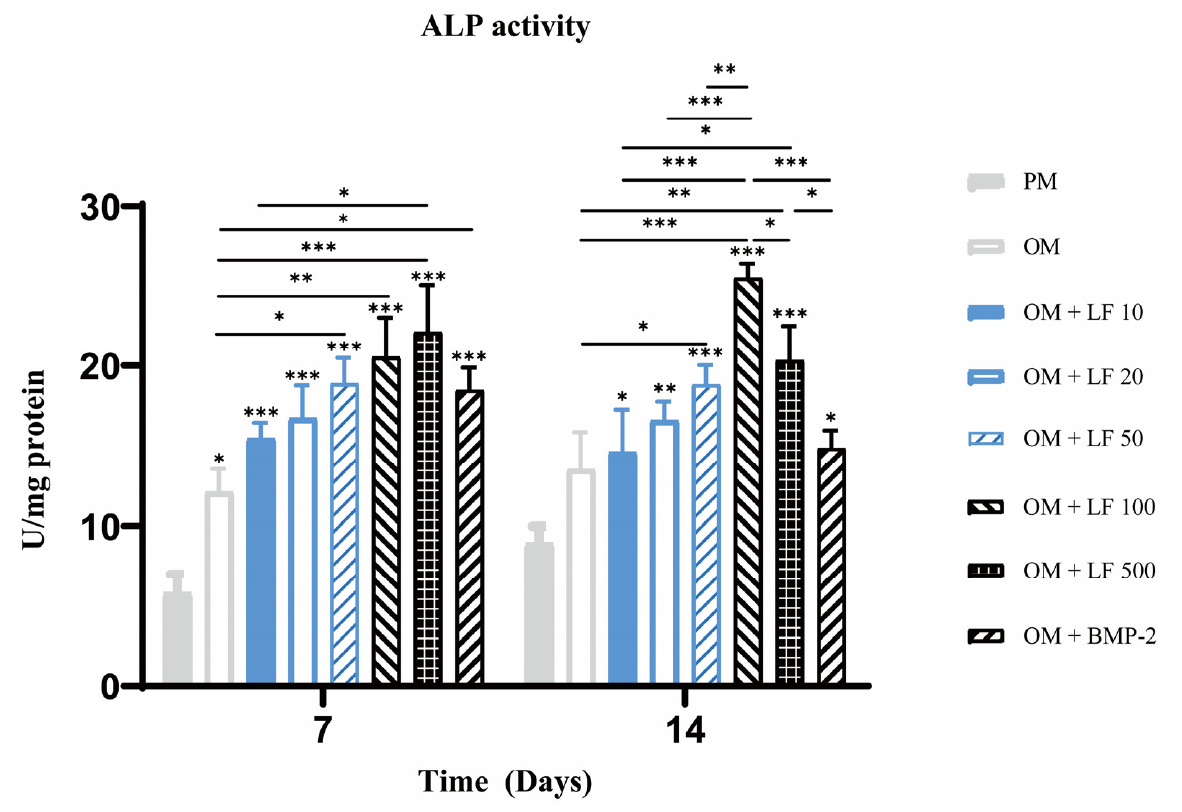
Figure 3. Analysis of ALP activity on days 7 and 14. On the top of a column without a capped line, seven OM groups’ significance levels are compared with that of PM group (* p < 0.05, ** p < 0.01, and *** p < 0.001).